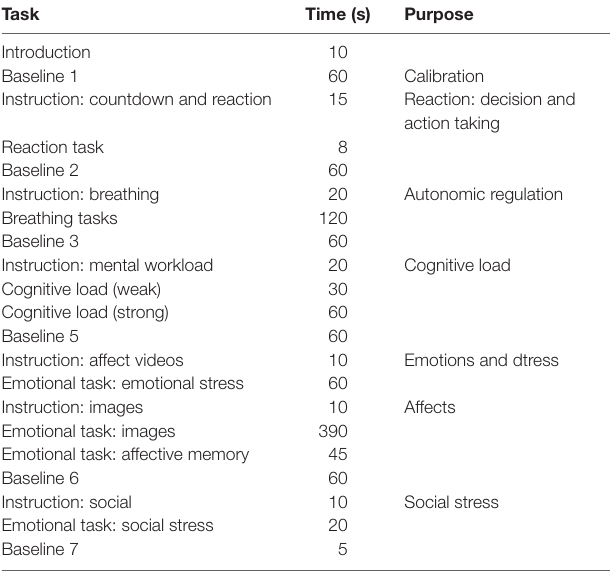
TABLE 2 | Progression of emotional and cognitive tasks tested. Task Time (s)